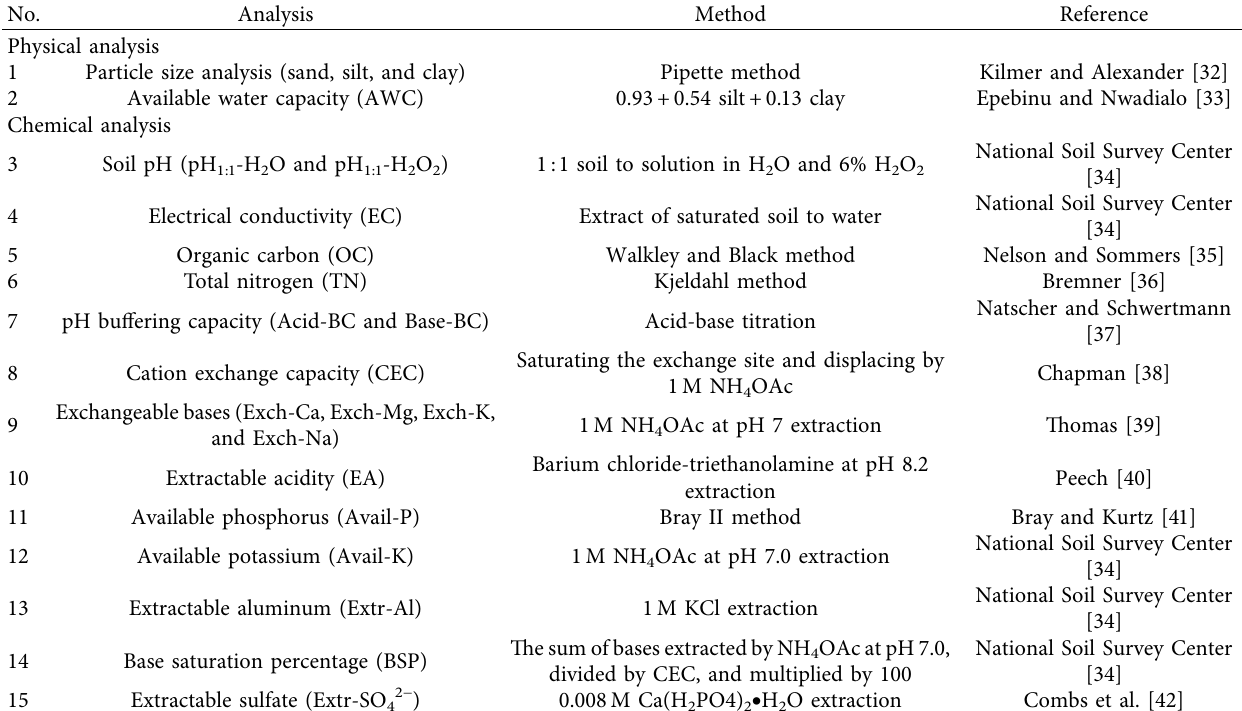
Table 2: Method of soil analyses.